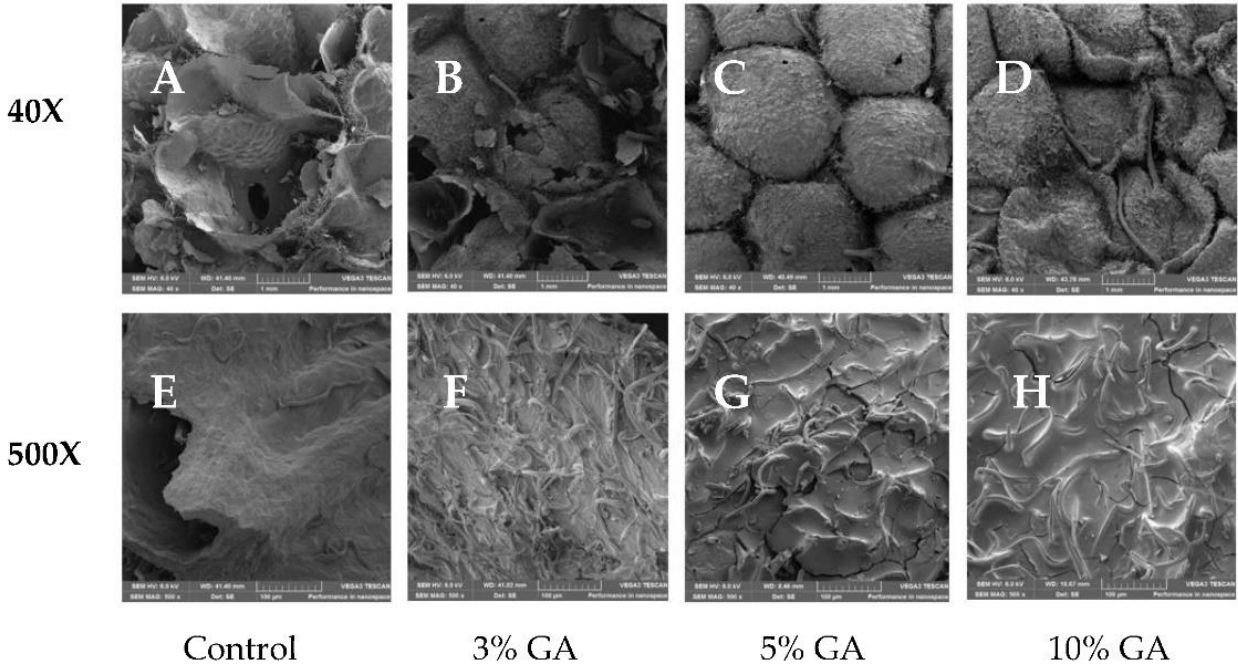
Figure 2. Scanning electron microscopy (SEM) images for the control samples, 3%, 5% and 10% GA-pretreated ( A – D ) (40X) and ( E – H ) (500X) and oven-dried (60 °C for 18 – 24 h) raspberries.